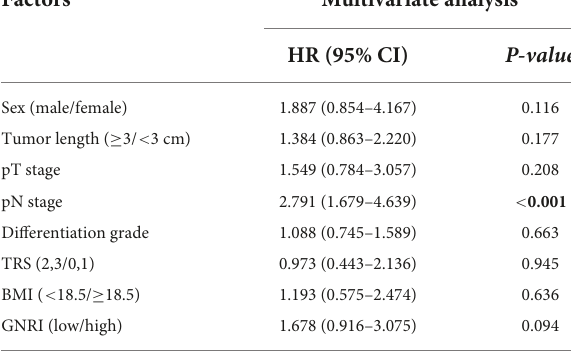
TABLE 4B Multivariate analysis of prognostic factors associated with overall